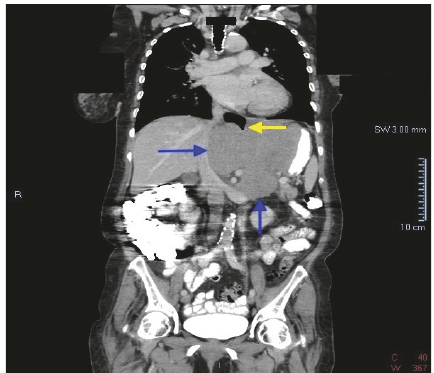
Figure 1: Barium swallow showing classic bird beak configuration consistent with achalasia.